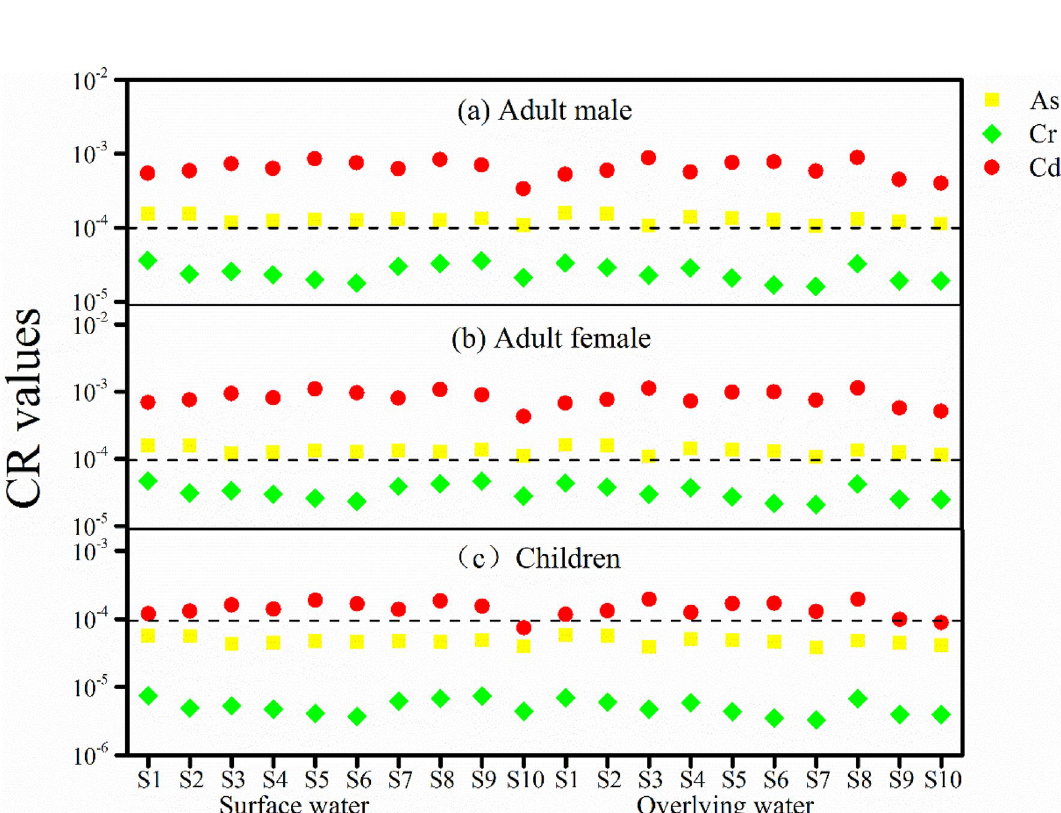
Figure 7. CR values of metals in the Xiangjiang River for ( a ) adult male, ( b ) adult female, and ( c )